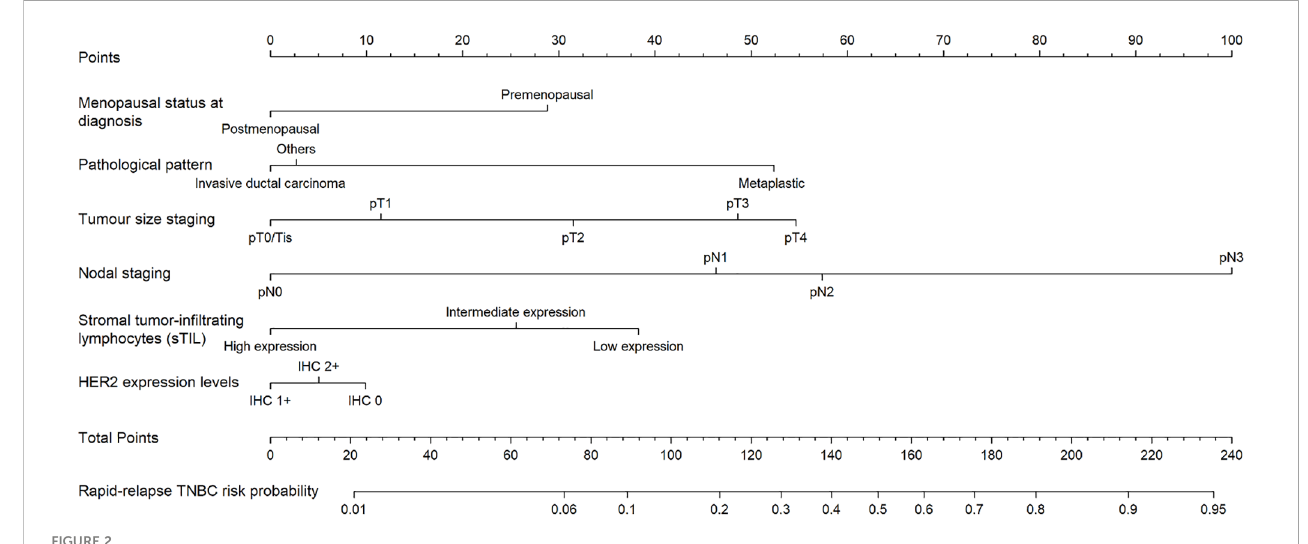
FIGURE 2 Nomogram for predicting rapid relapse of TNBC patients in the training set.